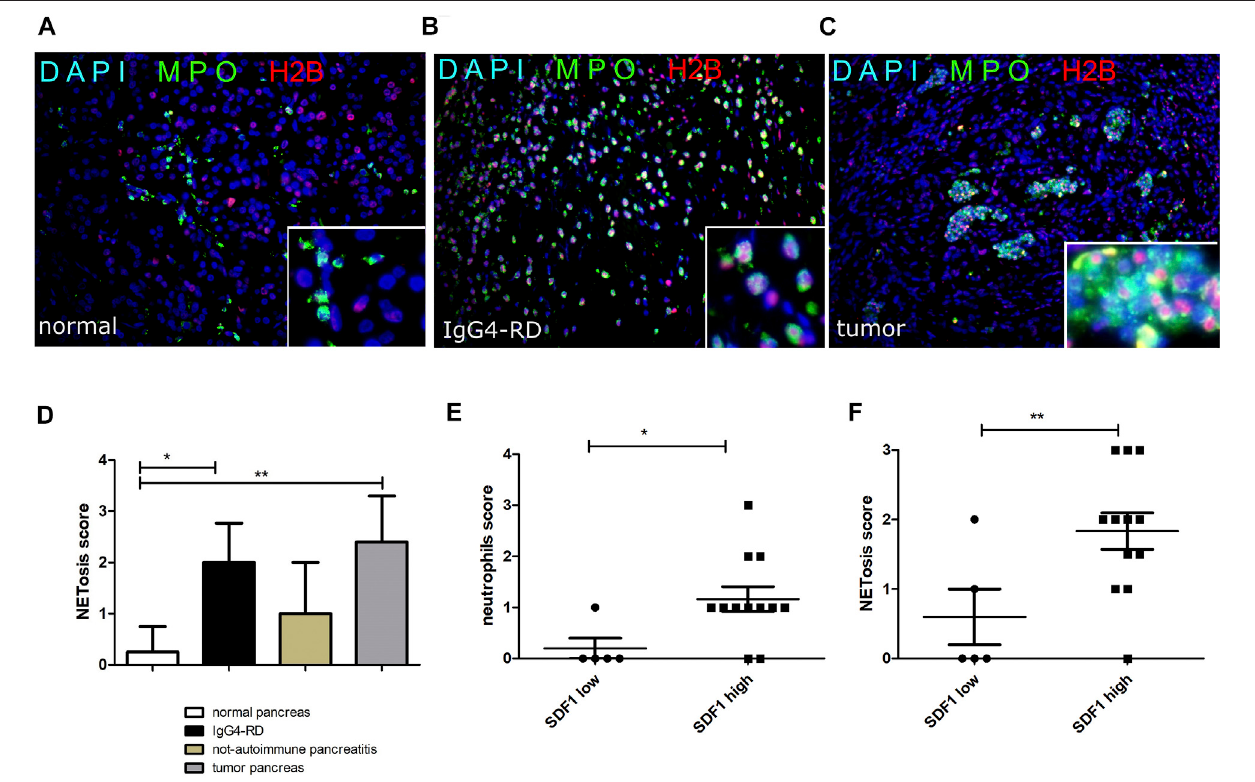
FIGURE 4 | NETs (double H2B and MPO staining) in normal pancreatic tissue (A) , IgG4-RD pancreas (B) , and tumor pancreas (C) . A semi-quantitative analysis of NETosis in thedifferent groupsisreported (D) .The neutrophil (E) and NETosis (F) scoreinpancreasre fl ectsthe SDF-1/CXCL12 expression inpancreatic tissue. p (cid:1) p < 0.05; pp (cid:1) p <